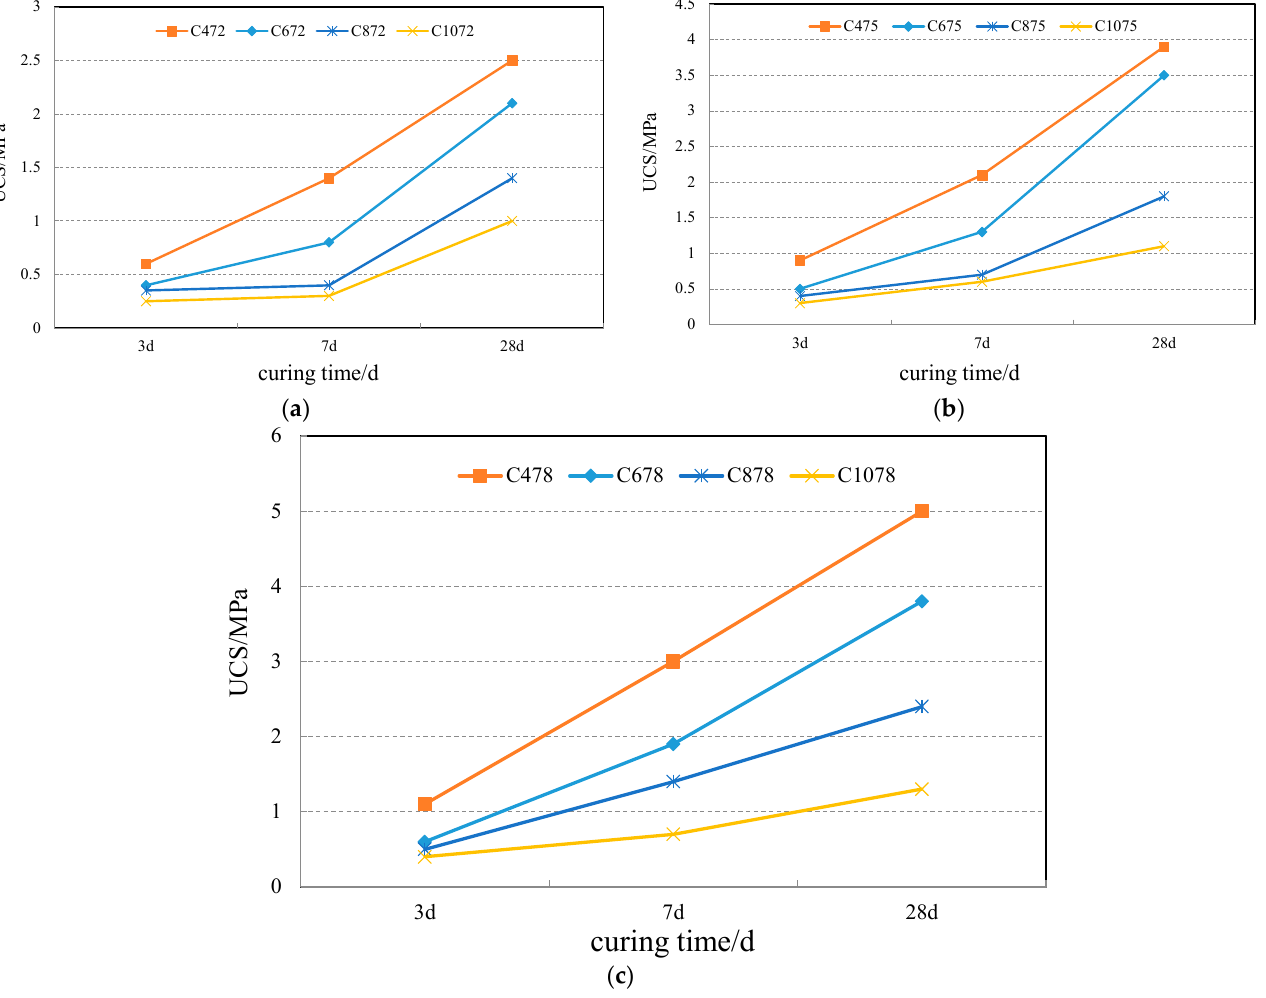
Figure 8. The UCS of CTB under the same solid content during the curing age of 28 days: ( a ) solid content of 72%; ( b ) solid content of 75% ( c ) solid content of 78%.